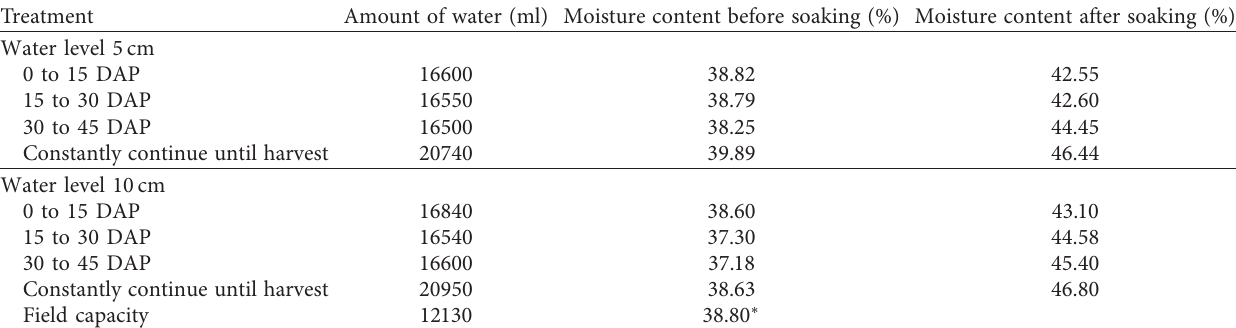
Table 1: Effect of water level and immersion time on the amount of water given to soil before and after immersion. Treatment